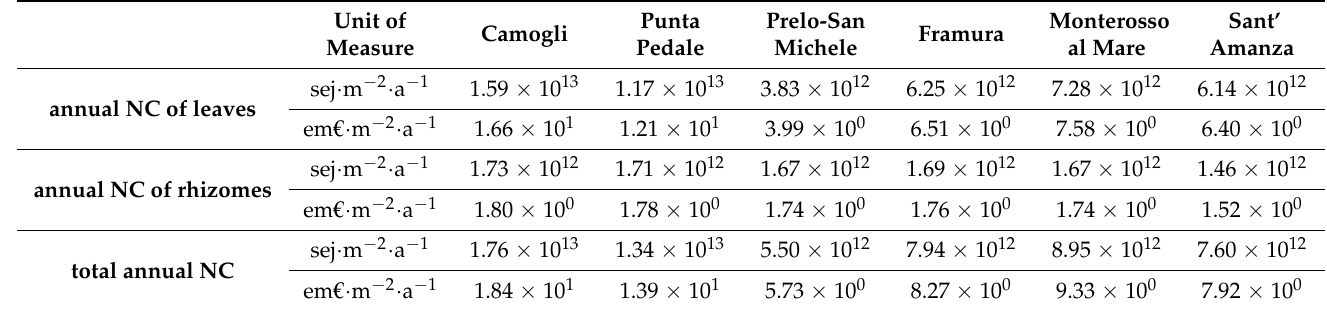
Table 6. Natural Capital stocked per time unit by the leaves and rhizomes components of P. oceanica and overall, expressed as sej m − 2 · a − 1 and em € · m − 2 · a − 1 , in the investigated sites. Unit of Measure Camogli Punta Pedale Prelo-San Michele Framura Monterosso al Mare Sant’ Amanza annual NC of leaves